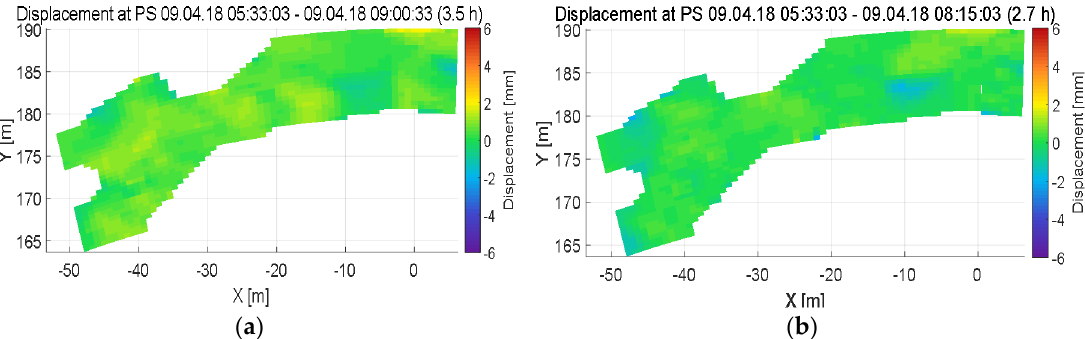
Figure 8. Deformation of the Yuehu bridge before and after atmospheric correction. ( a ) indicates before atmospheric correction; ( b ) indicates after atmospheric correction.